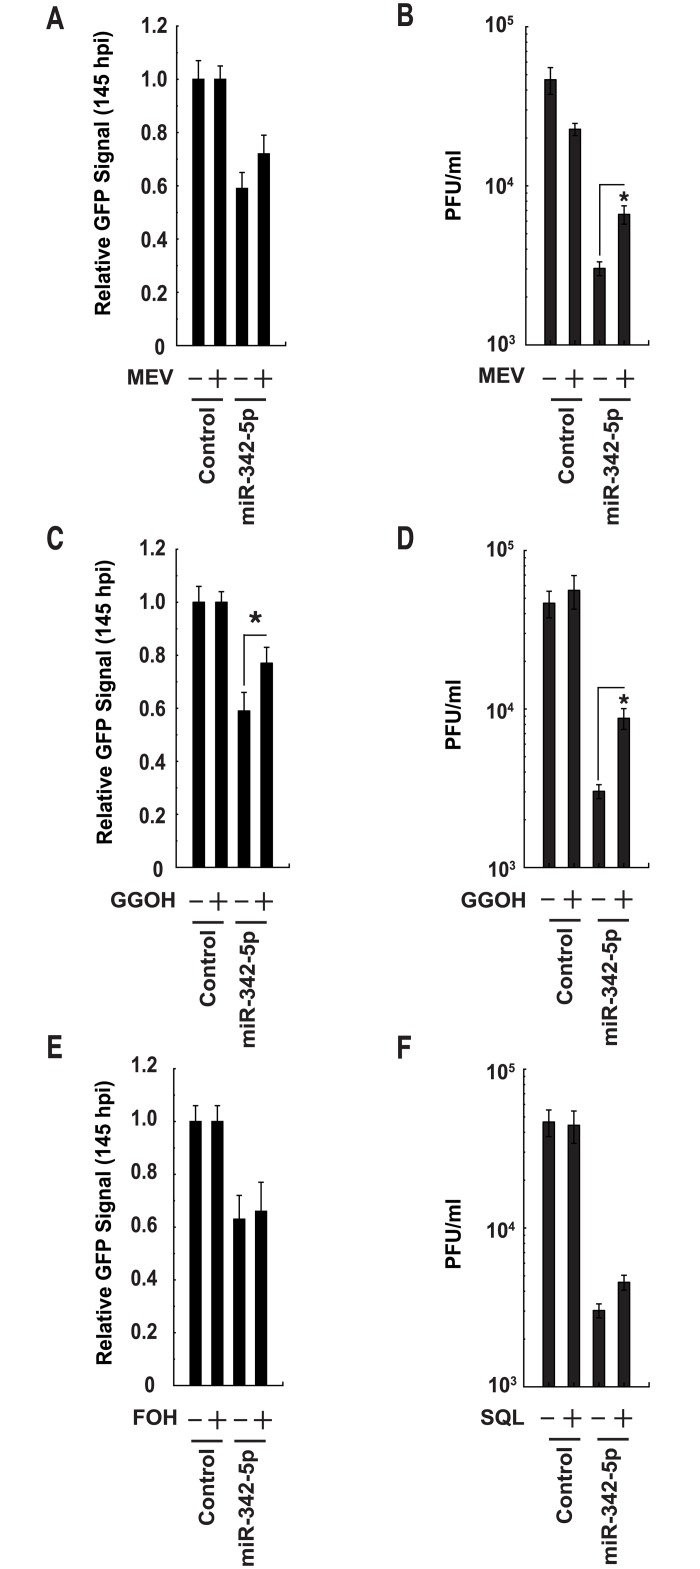
Inhibitory effects of miR-342-5p on MCMV are mediated through regulation of the mevalonate-isoprenoid pathway.(A) MCMV-GFP replication in pMEF transfected with control miRNA or miR-342-5p and then cultured with MEV (1 μM final concentration). Data are mean +/− SEM (n = 39). (B) MCMV PFU production in pMEF transfected with control miRNA or miR-342-5p and then cultured with MEV (20 μM final concentration). Data are mean +/− SEM (n = 4). * p ≤ 0.05. (C) MCMV-GFP replication in pMEF transfected with control miRNA or miR-342-5p and then cultured with GGOH (1 μM final concentration). Data are mean +/− SEM (n = 39). * p ≤ 0.05. (D) MCMV PFU production in pMEF transfected with control miRNA or miR-342-5p and then cultured with GGOH (20 μM final concentration). Data are mean +/− SEM (n = 4). * p ≤ 0.05. (E) MCMV-GFP replication in pMEF transfected with control miRNA or miR-342-5p and then cultured with FOH (1 μM final concentration). Data are mean +/− SEM (n = 19). (F) MCMV PFU production in pMEF transfected with control miRNA or miR-342-5p and then cultured with SQL (20 μM final concentration). Data are mean +/− SEM (n = 3). * p ≤ 0.05.